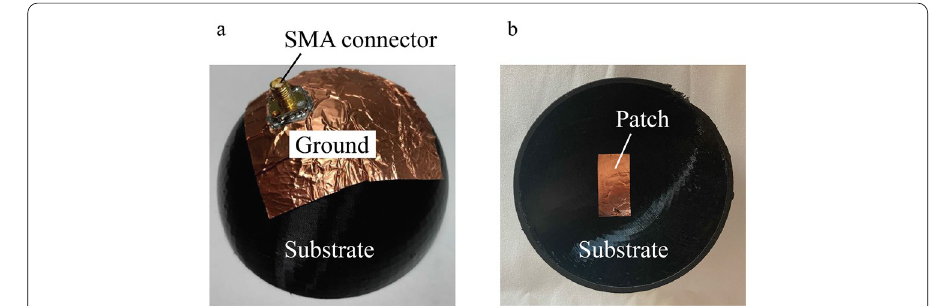
Fig. 3 Antenna sample (100%-infill): a ground plane side and b patch side